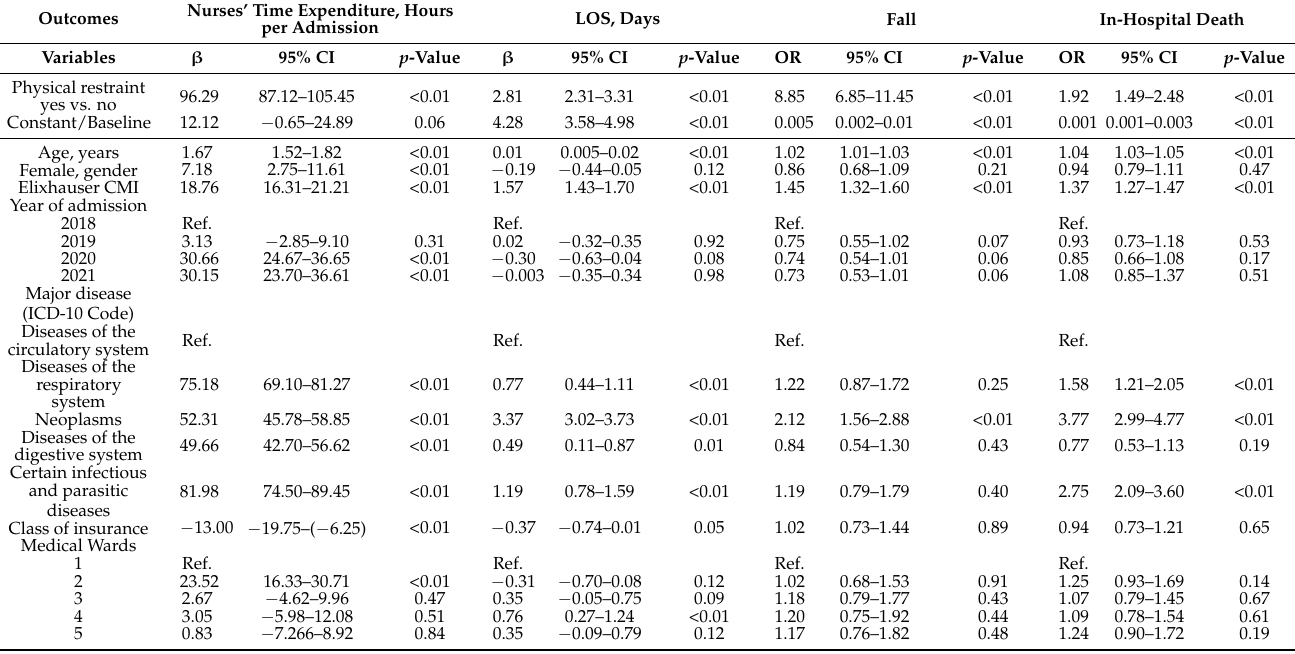
Table 3. Outcomes multivariable adjusted by important clinical confounders.